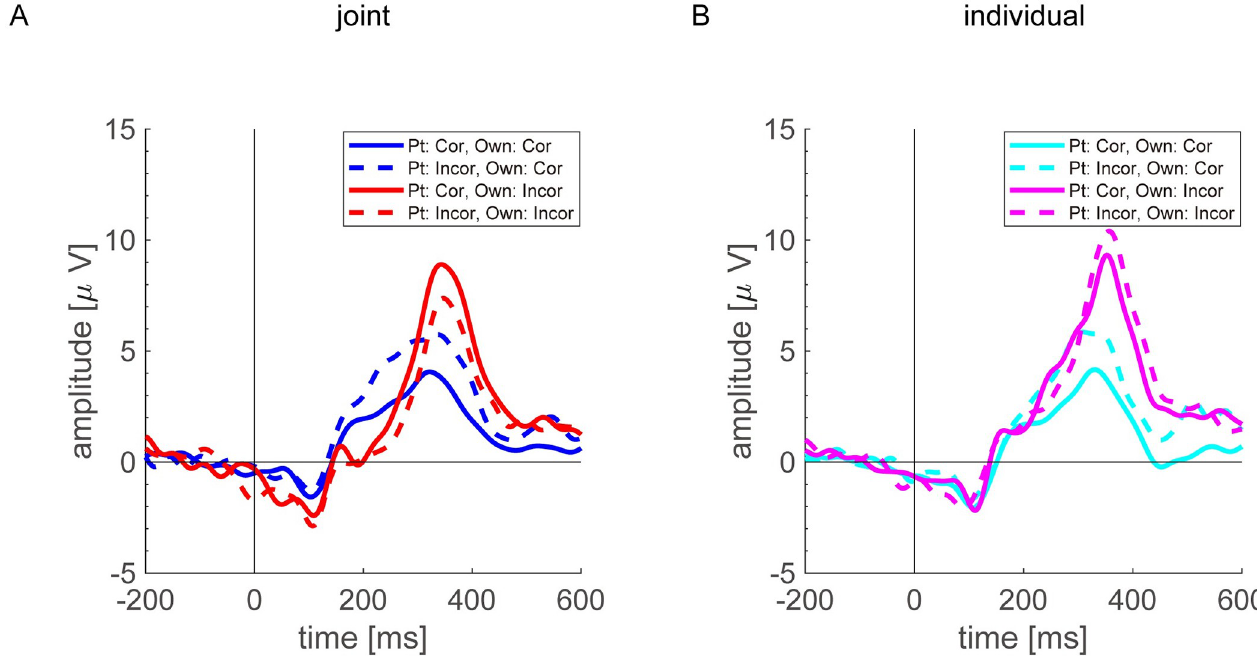
Fig 4. Grand-averaged event-related potentials of the averaged data of the FC3, FCz, and FC4 channels in (A) joint and (B) individual conditions.